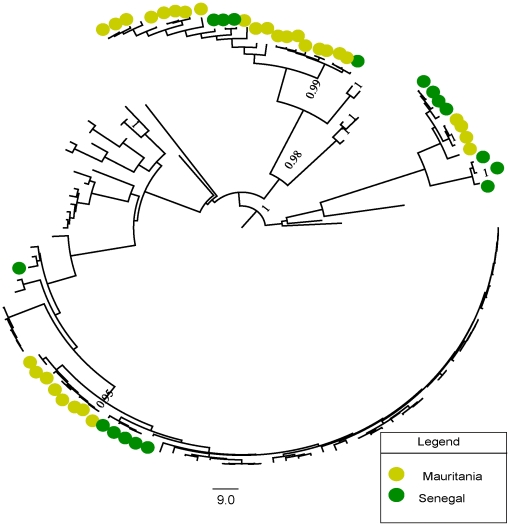
Maximum clade credibility (MCC) tree for the long (L) segment.Relationship among 126 strains of RVFV isolated from different localities and countries. Samples from Mauritania and Senegal are shown by green and yellow dots respectively. The recurrent independent clustering of green and yellow dots suggests multiple introductions of RVFV into these countries throughout the 20th century. Posterior probability values greater than 90% are shown near tree nodes.